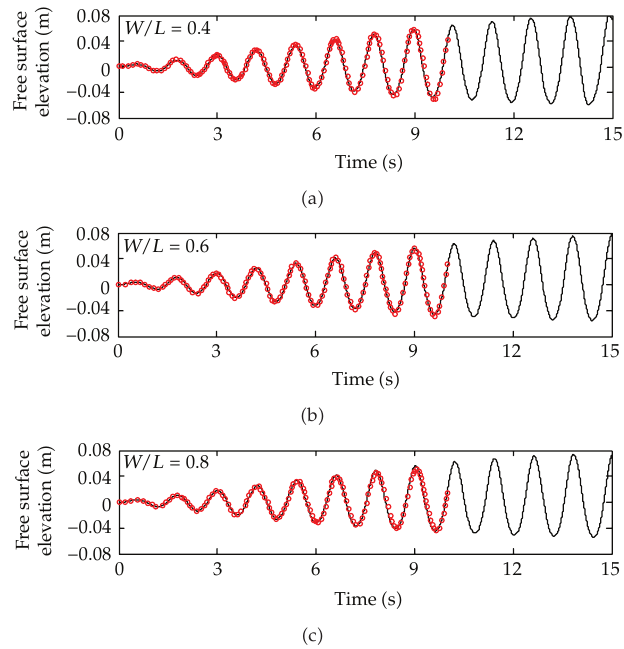
Figure 3: Comparisons of the time history of free surface elevation at the right wall of the ba ffl ed tank between the present numerical results (cid:6) solid line (cid:7) and the numerical data of Biswal et al. (cid:4) 16 (cid:5) (cid:6) circle (cid:7)